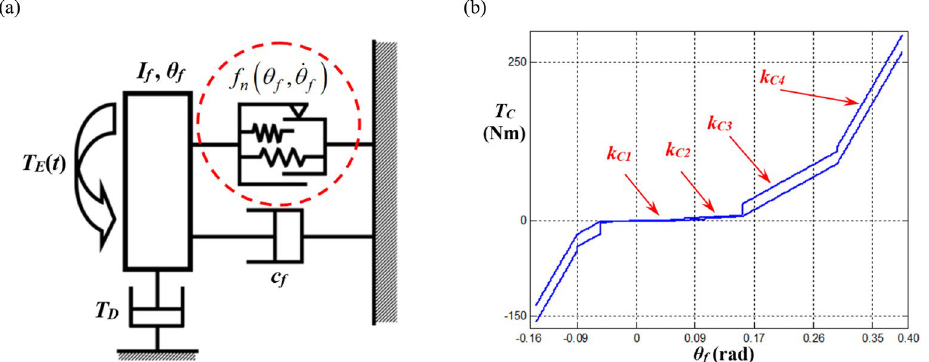
Figure 2. A single-degree-of-freedom system with piecewise-type nonlinearities based on a physical system: ( a ) a nonlinear torsional system model with one DOF; ( b ) Torque T C ( δ 1 ) profile for a multi-staged clutch damper 8